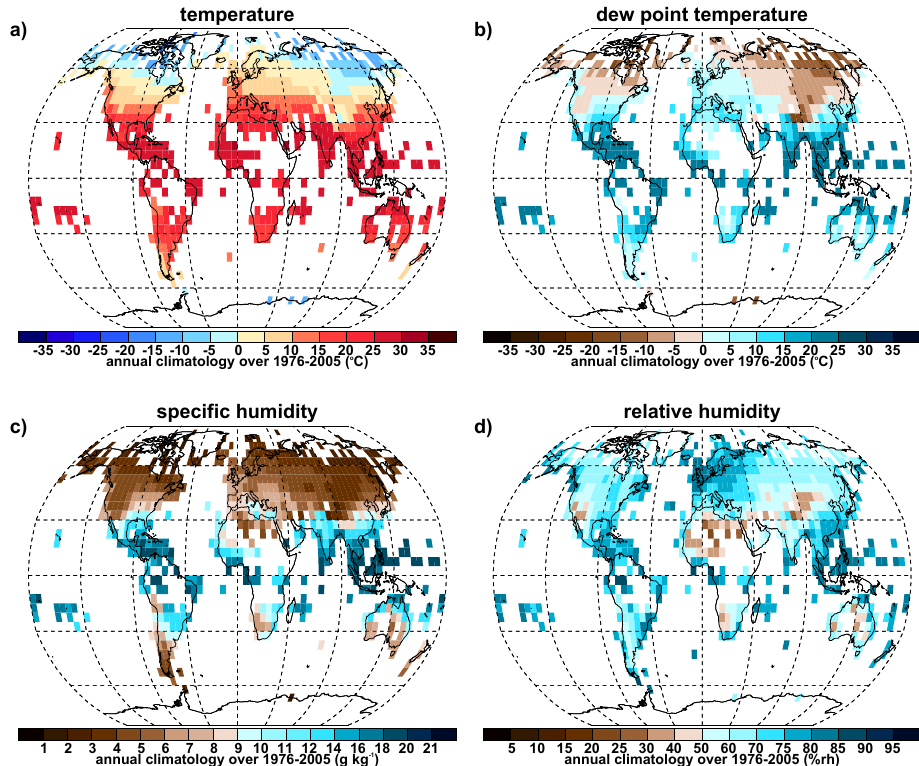
Figure 6. Annual climatologies (1976–2005) for (a) temperature, (b) dew point temperature, (c) specific humidity and (d) relative humidity. See Fig. SM5 for other